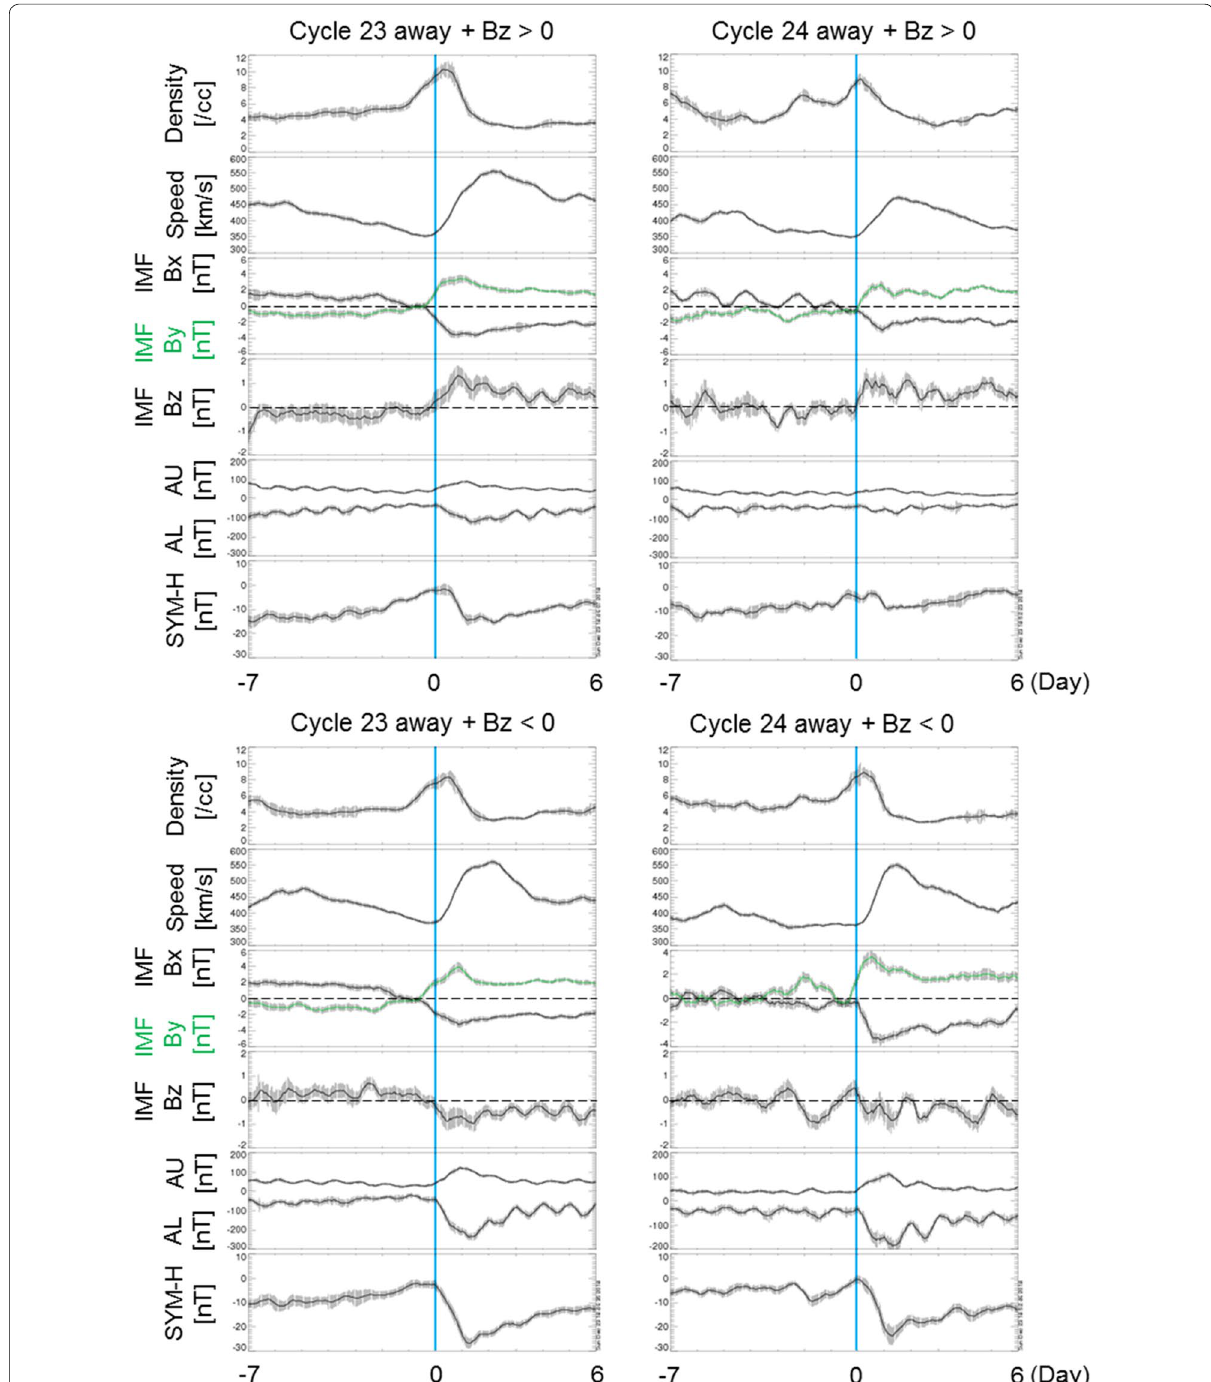
Fig. 9 Half-day averaged variation of solar wind proton density, solar flow velocity, and IMF, geomagnetic indices in the case of “away” (IMF Bx < 0 and By > 0) during solar cycle 23 and 24. The vertical light blue line represents the start time of an enhancement of solar wind velocity around the Earth’s orbit. The error bar represents the standard